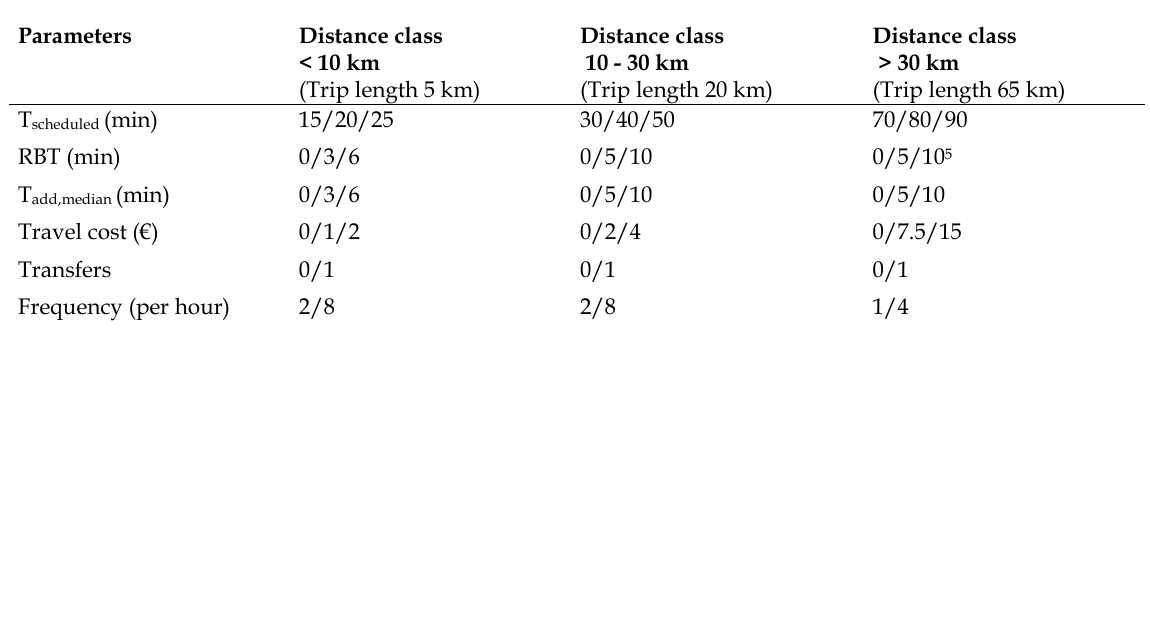
Table 4. Attribute